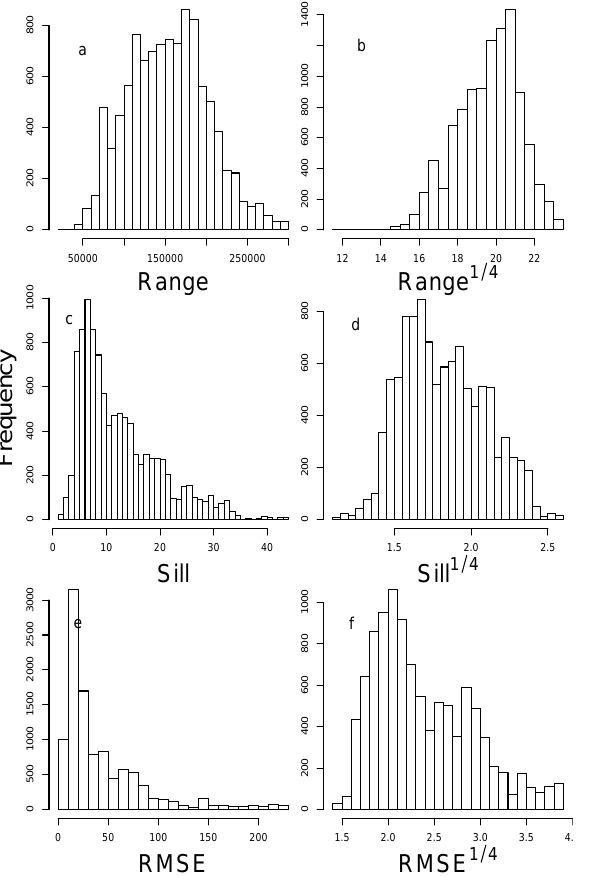
Fig. 6. Histograms of the range, sill, and RMSE before ( a , c , and e , respectively) and after ( b , d , and f , respectively) a sqrt-sqrt trans- form.